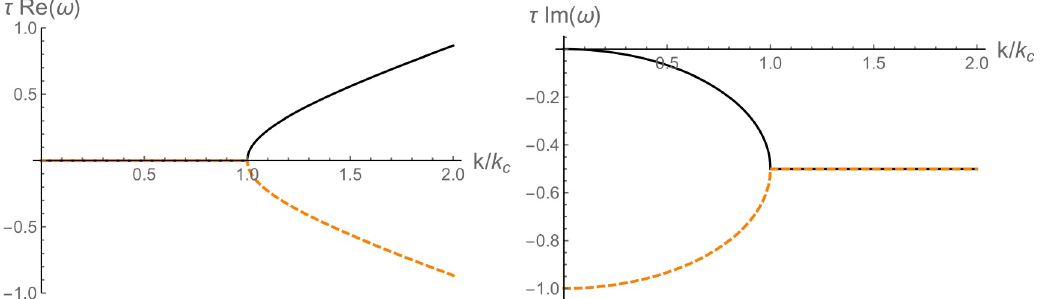
Figure 1 . Real (left) and imaginary (right) parts of the hydrodynamic (solid black) and nonhy- drodynamic (dashed orange) modes in the shear channel of the Müller-Israel-Stewart theory, as functions of momentum. The modes are given by